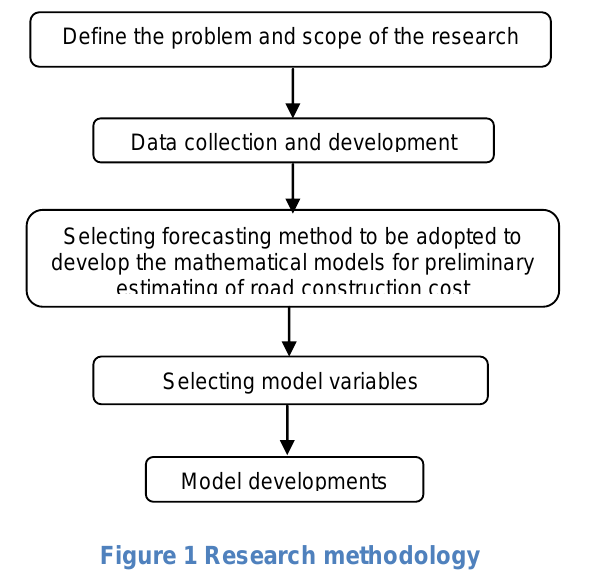
Figure 1 Research